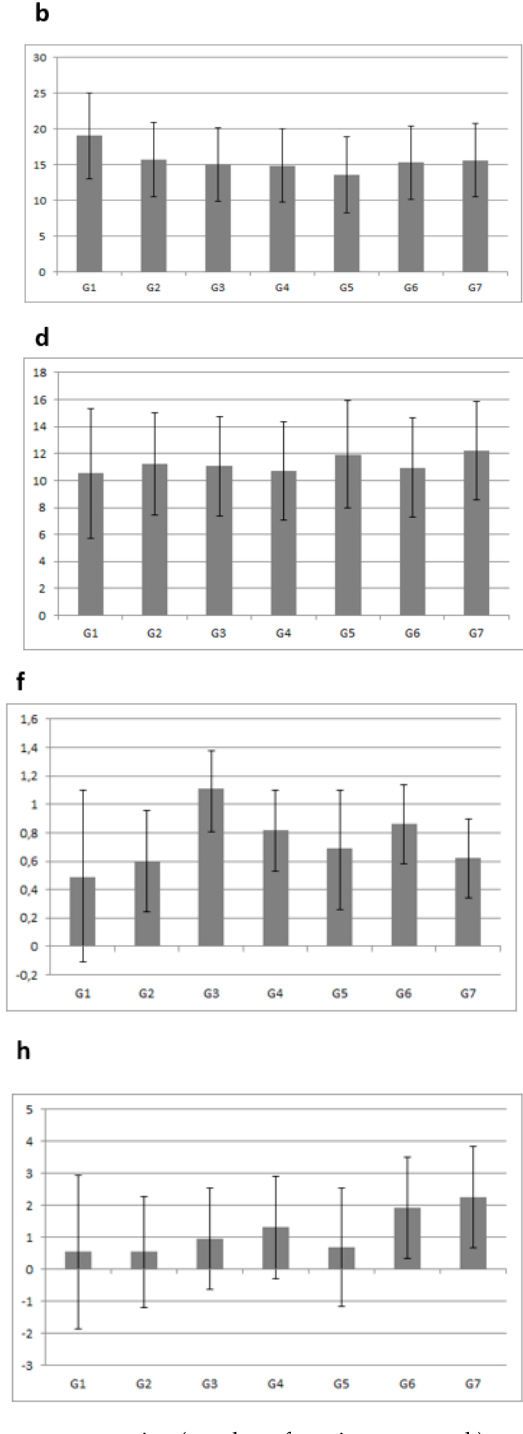
Figure 2. Marginal means and SD of food and beverage consumption (number of portions per week) according to PA and ST recommendations. G1: met both recommendations at T0 and met both recommendations at T1; G2: met both recommendations at T0 and met one of the recommendations at T1; G3: met one of the recommendations at T0 and met both recommendations at T1; G4: met one of